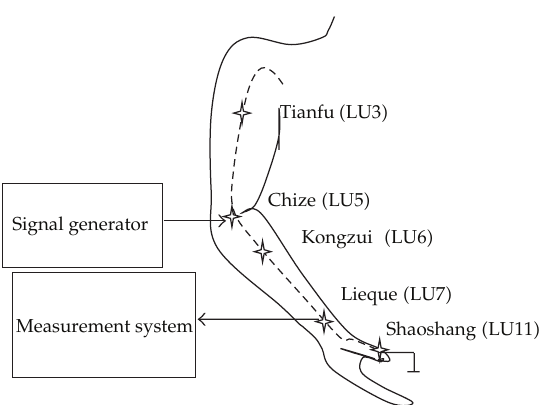
Figure 1: Experimental configuration of meridian signal measurement.